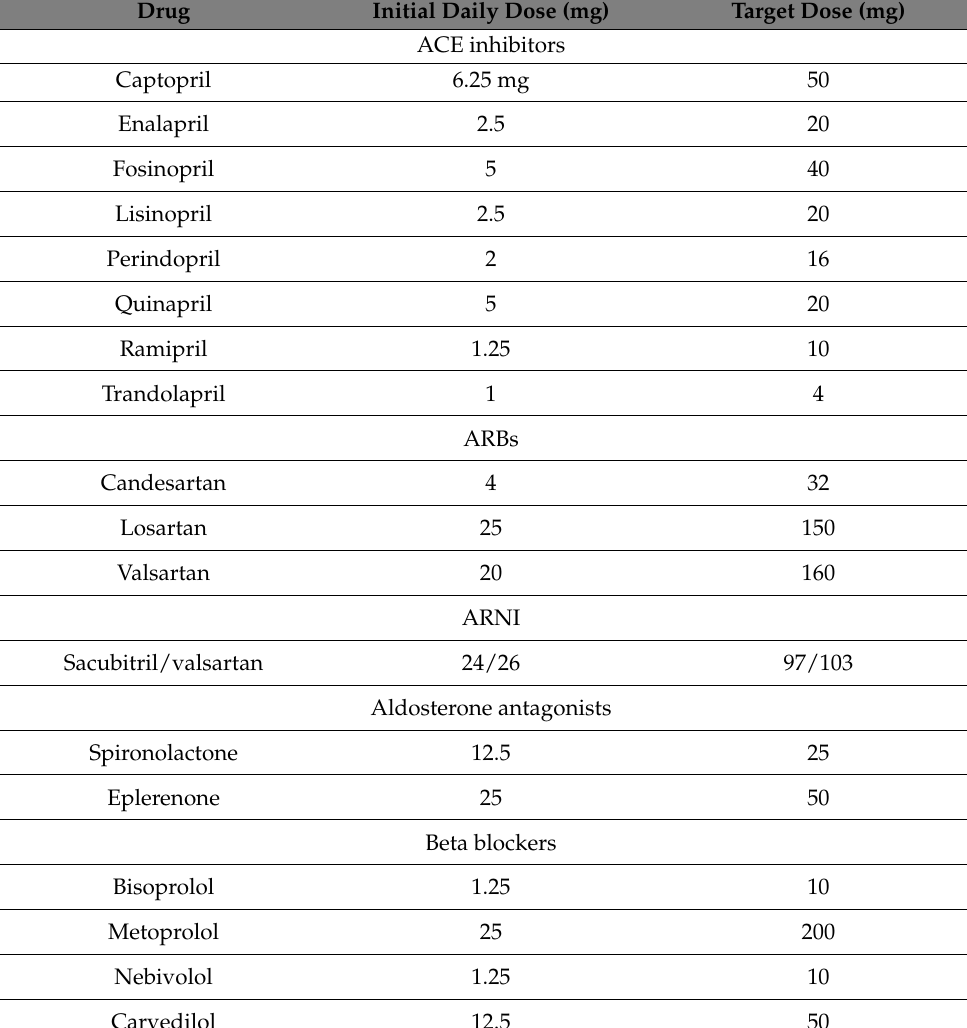
Table 1. Drugs of GDMT and their target dose defined by AHA guidelines in 2017 (Yancy et al.). Drug Initial Daily Dose (mg) Target Dose (mg) ACE inhibitors